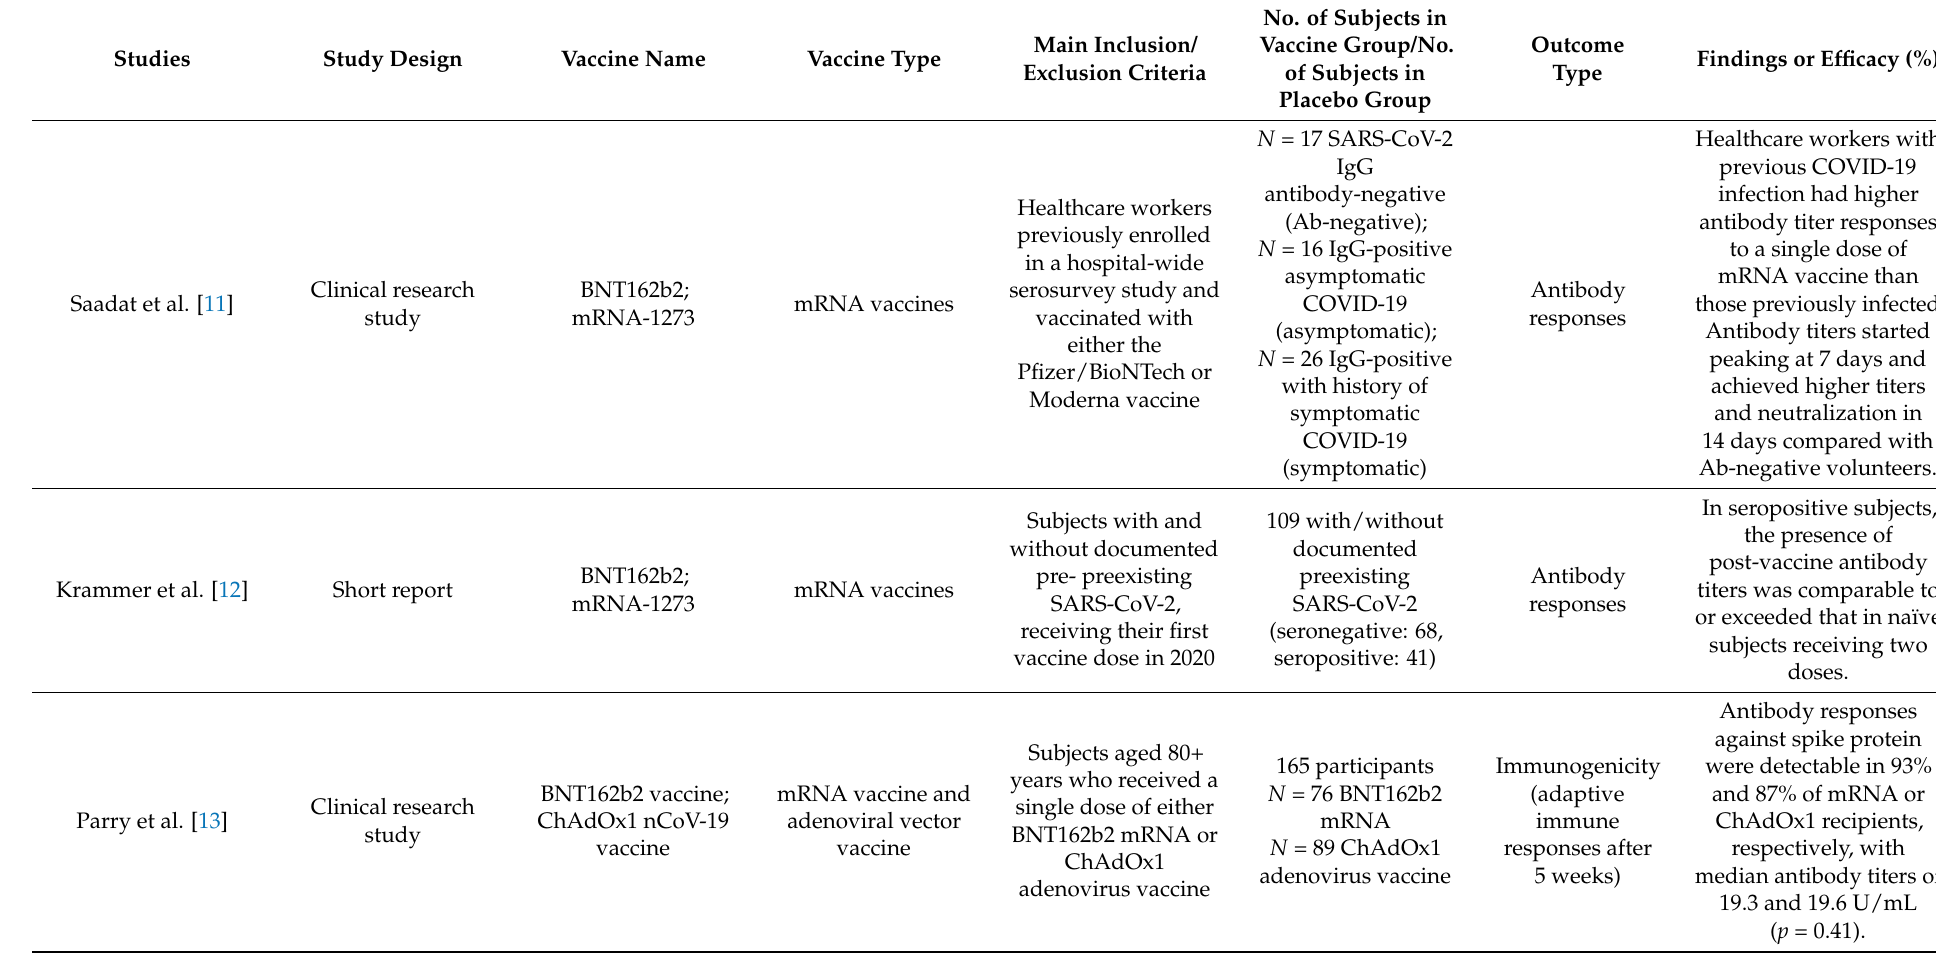
Table 1. Main studies and findings on vaccine